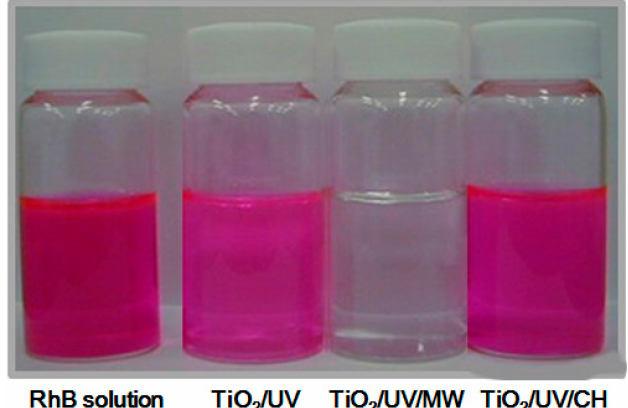
Figure 2. Visual comparison of color fading in the degradation of RhB solutions (0.05 mM) subsequent to being subjected to various degradation methods for 150 min. From left to right: initial RhB solution; RhB subjected to photoassisted degradation (UV); EhB subjected to integrated microwave-/photo-assisted degradation (UV/MW); RhN subjected to thermal- and photo-assisted degradation (UV/CH). Reproduced from